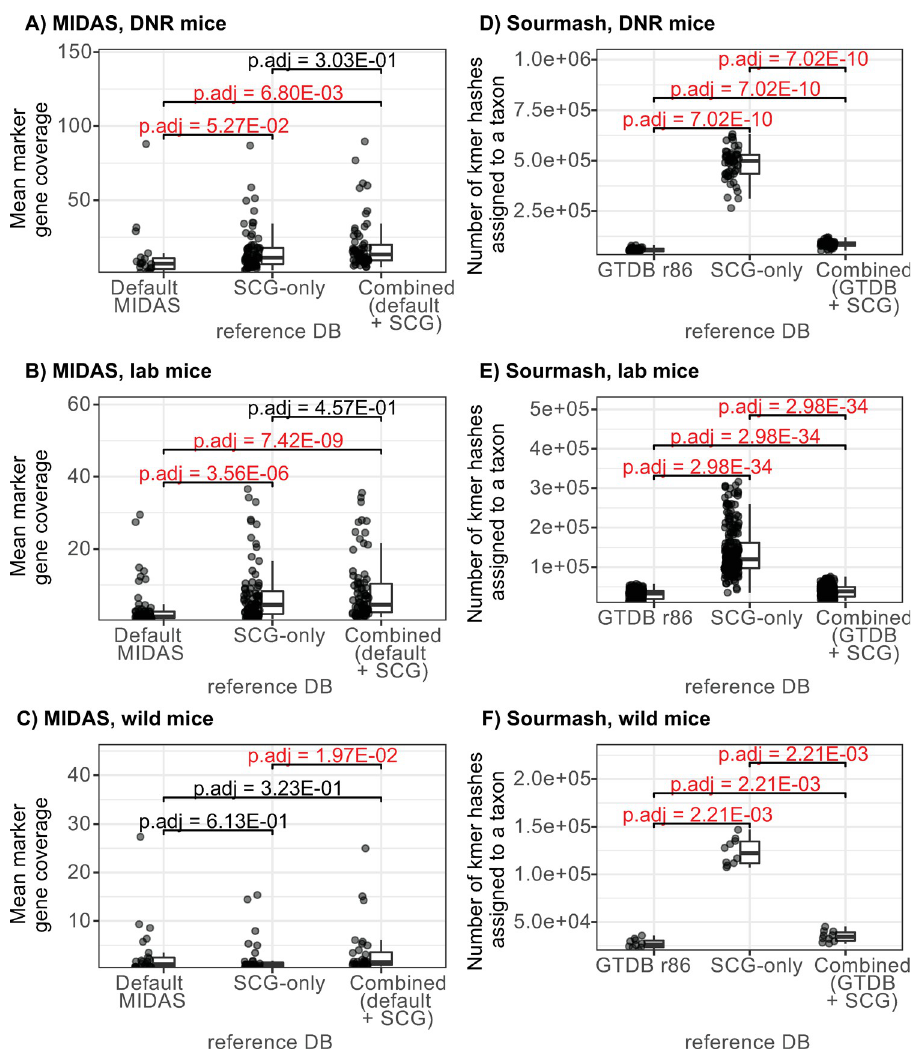
Fig 4. Taxonomic classifiers perform better on murine metagenomic samples when their reference databases are augmented with SCG data. Boxplots and swarmplots show the performance metrics of two classifiers (left column— mean marker gene coverage by MIDAS, right column—total number of kmer hashes assigned by sourmash) on three test metagenomic inputs (1st row—samples from DNR mice, 2nd row—samples from other lab mice, 3rd row— samples from wild mice). Brackets over the boxplots display FDR-adjusted (Benjamini-Hochberg procedure) p-values from pairwise comparisons with the unpaired (MIDAS) and paired (sourmash) Wilcoxon rank-sum test. Text over significance brackets is colored red in cases where the adjusted p-value is less than